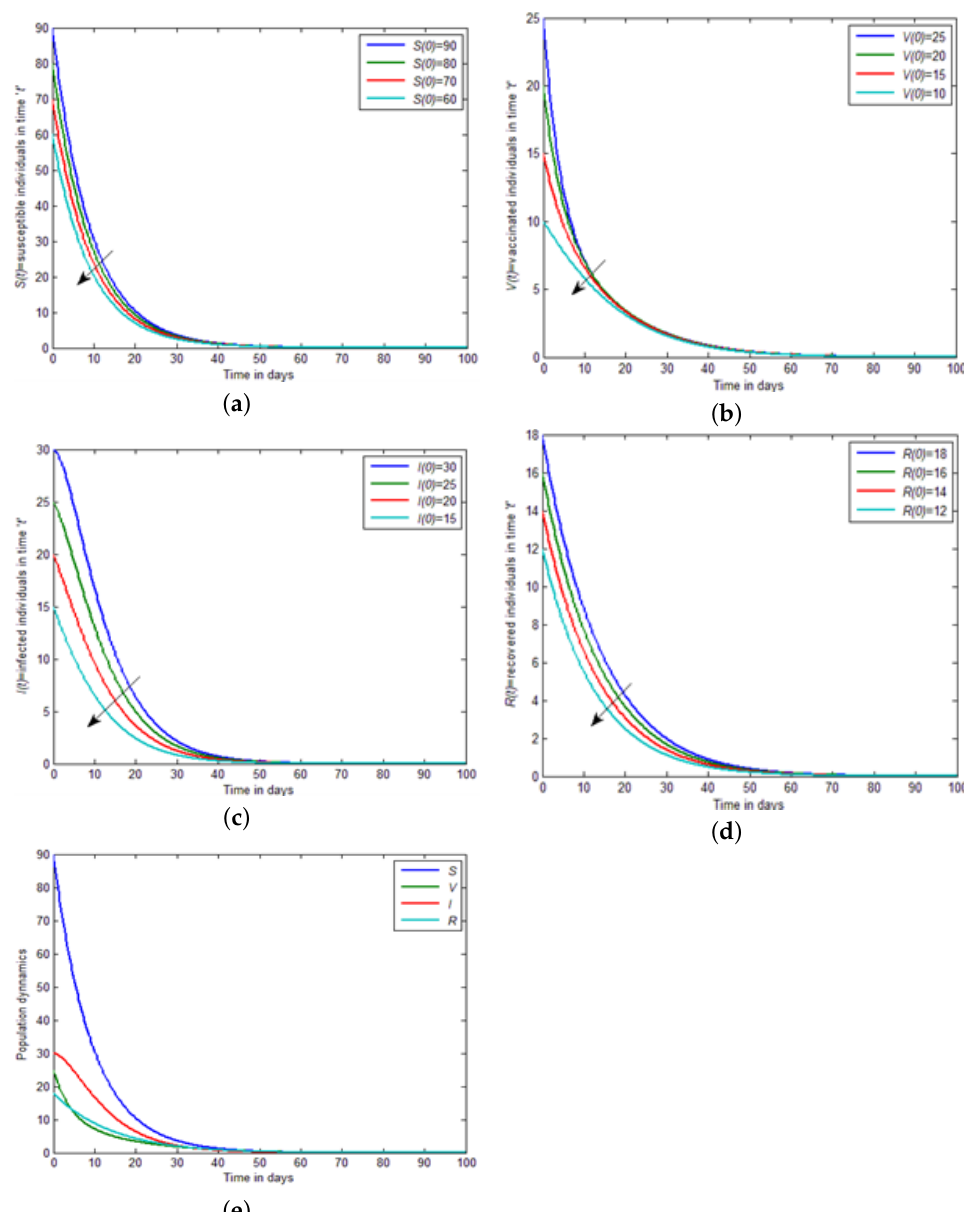
Figure 4. The population dynamics of ( a ) S ( t ) , ( b ) V ( t ) , ( c ) I ( t ) , and ( d ) R ( t ) for different values of ‘ ξ 2 ’ and ( e ) different values of the initial